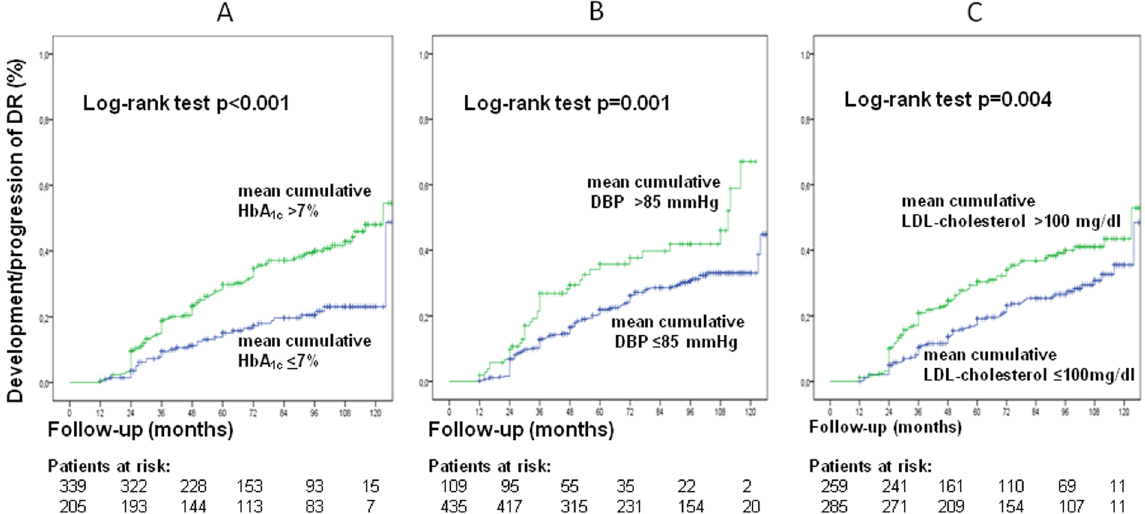
Figure 1. Kaplan-Meier estimation of cumulative diabetic retinopathy incidence or progression in type 2 diabetic patients grouped according to mean exposure during follow-up of HbA 1c ( > 7.0%, 53 mmol/mol, panel A), of diastolic blood pressure ( > 85 mmHg, panel B) and of LDL-cholesterol ( > 2.59 mmol/L, 100 mg/dL, panel